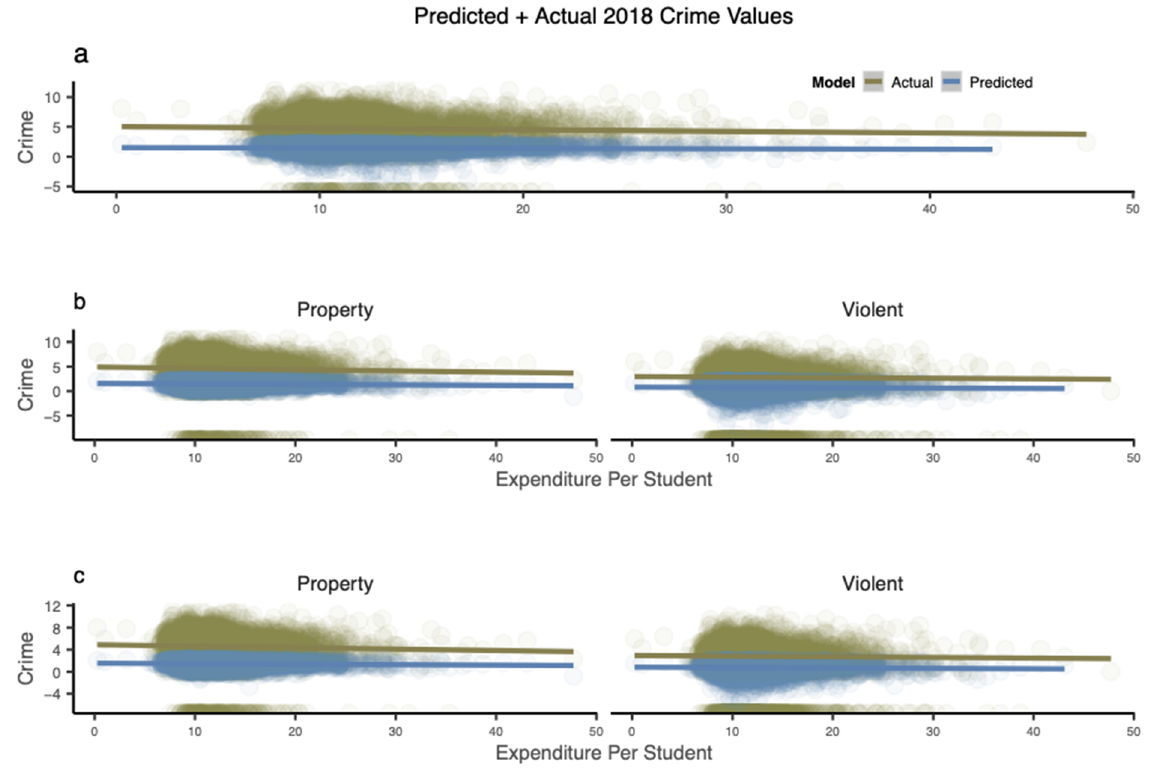
Figure 7. Predictions for first (total crime), second (education spending interaction with crime), and third (interactions among all variables with crime) crime models compared with actual 2018 crime data (green). The y-axis represents the crime values (logged) predicted from our model. The x-axis is school district spending per student (thousands of dollars).